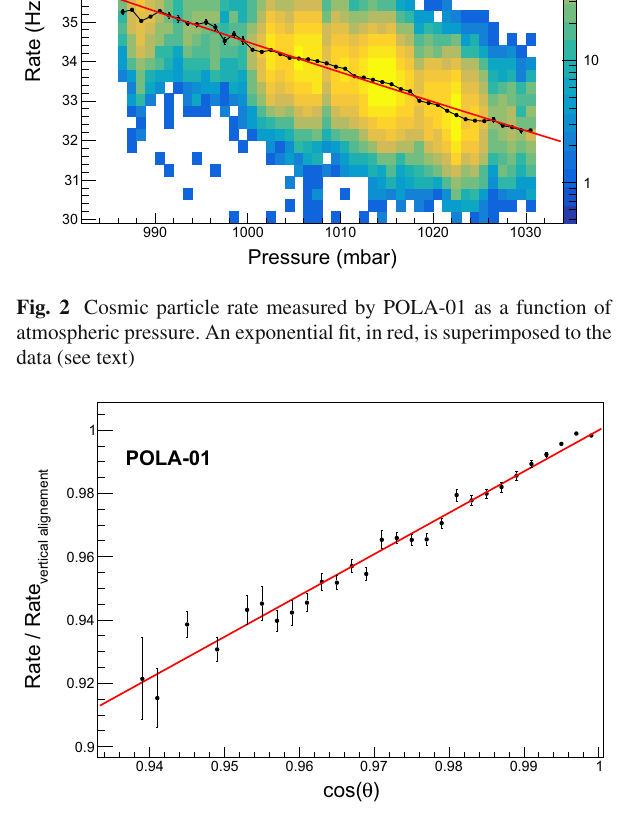
Fig. 3 Correlation between the cosmic particle rate measured by the POLA-01 detector on board of the sailboat Nanuq and its inclination with respect to the vertical. A linear fit, in red, is superimposed to the